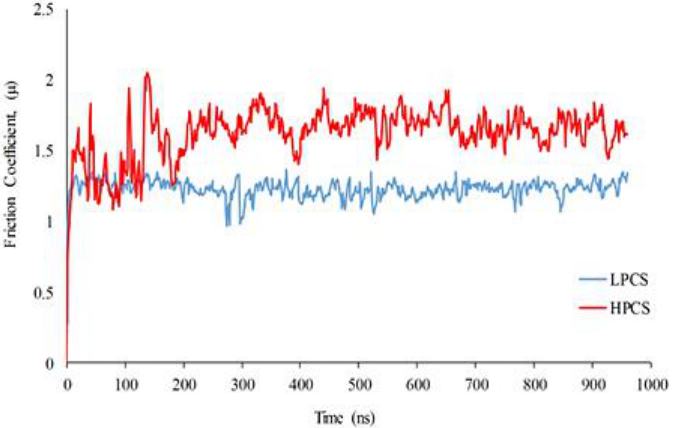
Figure 6. Friction coefficient at 2 N load of Al coatings using HPCS and LPCS. Furthermore, Figure 7a,b demonstrate the variation of friction coefficients and the wear rate of Al coatings as a function of applied load (2 N, 3 N, and 5 N) deposited using HPCS and LPCS, respectively. The friction coefficient for both the HPCS and LPCS coatings decreases as the load increases from 2 N to 5 N. This shows that CS technology decreases the friction coefficient [22]. Comparing the HPCS and LPCS coatings, the friction coefficient of the LPCS coating decreased gradually from 1.343 to 1.297 and then to 0.798 with small gaps in the values as the load was increased, whereas the HPCS coating decreased from 1.609 to 1.067 and then to 0.807 with larger gaps. As stated in [22], dense coatings with low porosity generate a low friction coefficient that improves wear